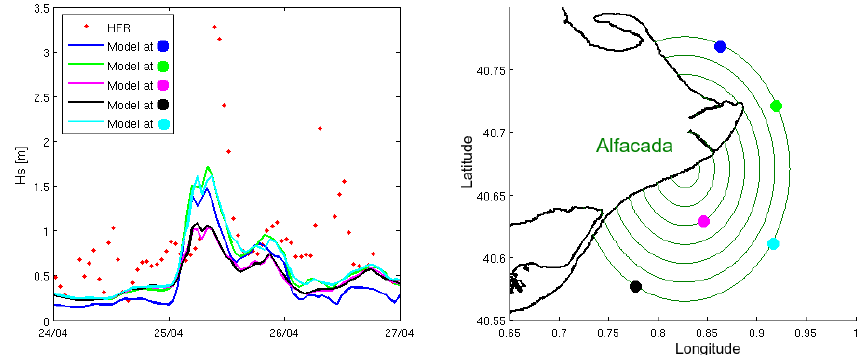
Figure 17. Treated HF radar data of the Alfacada antenna compared with different modeled time series from points located within the antenna range. Time series data are for